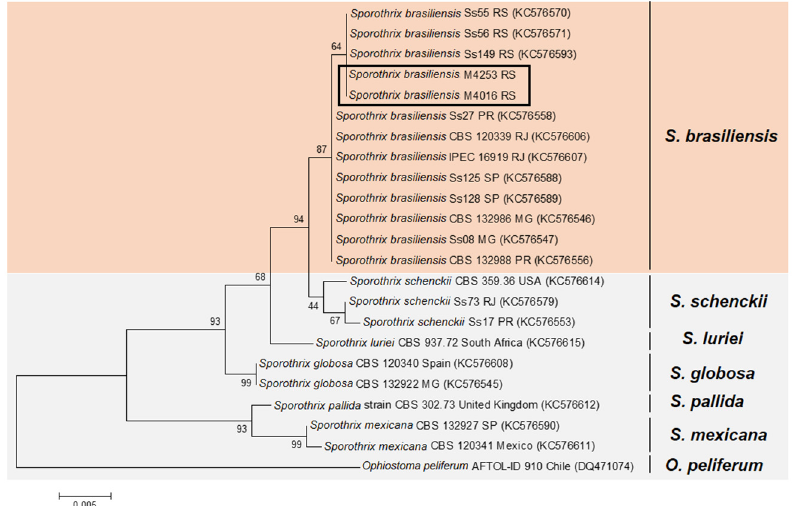
Figure 1. Genotyping of Sporothrix brasiliensis strains from Rio Grande do Sul. Maximum likelihood method based on partial sequences of the translation elongation factor-1 alpha (EF1a). A bootstrap value of 1000 is represented in the branches. Orange marked: S. brasiliensis strains; Gray marked: other Sporothrix species. Rectangle: Isolates included in our